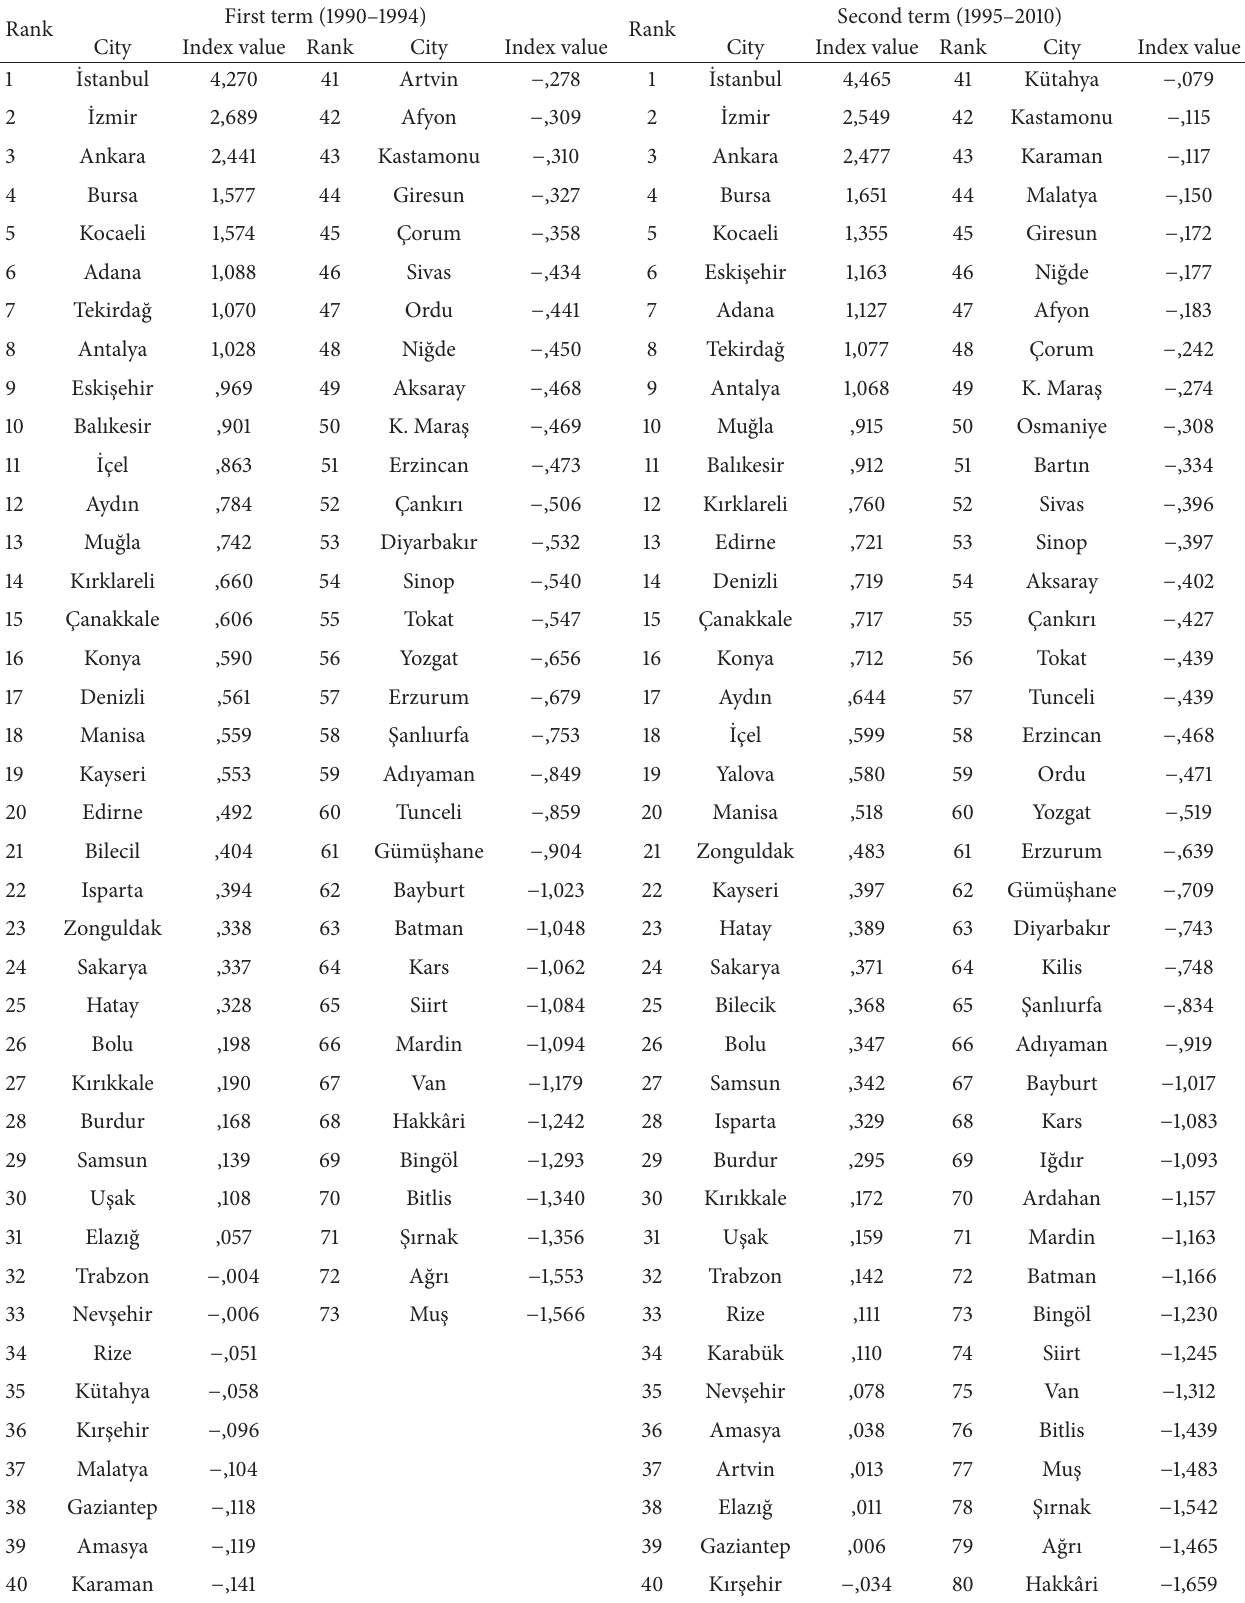
Table 7: Welfare